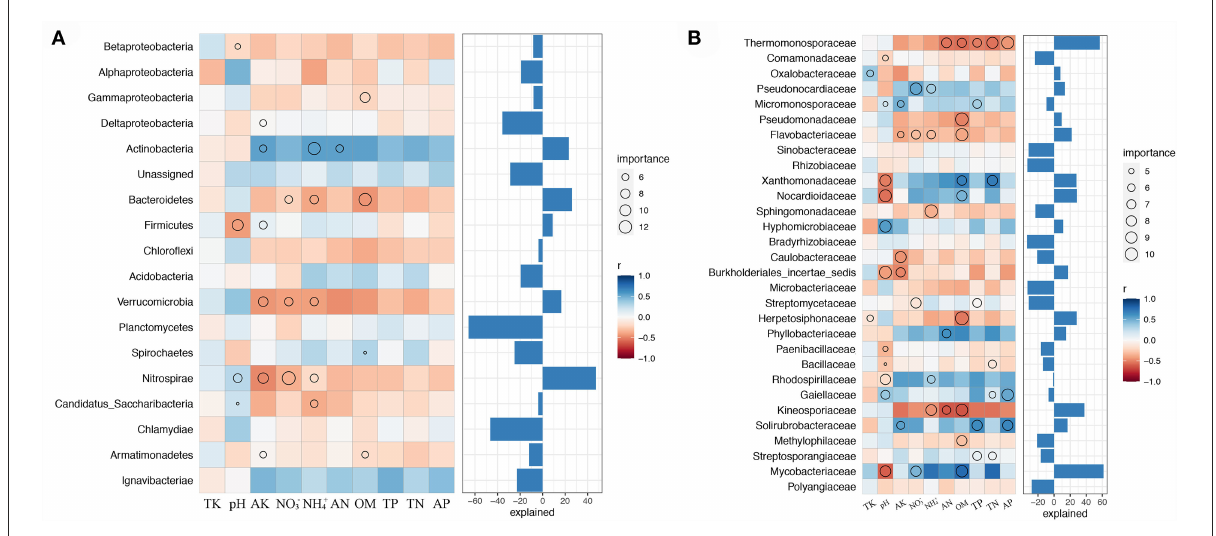
FIGURE5 Biological contributions of dominant bacterial phyla (A) and families (B) for soil nutrient cycling analyzed by random